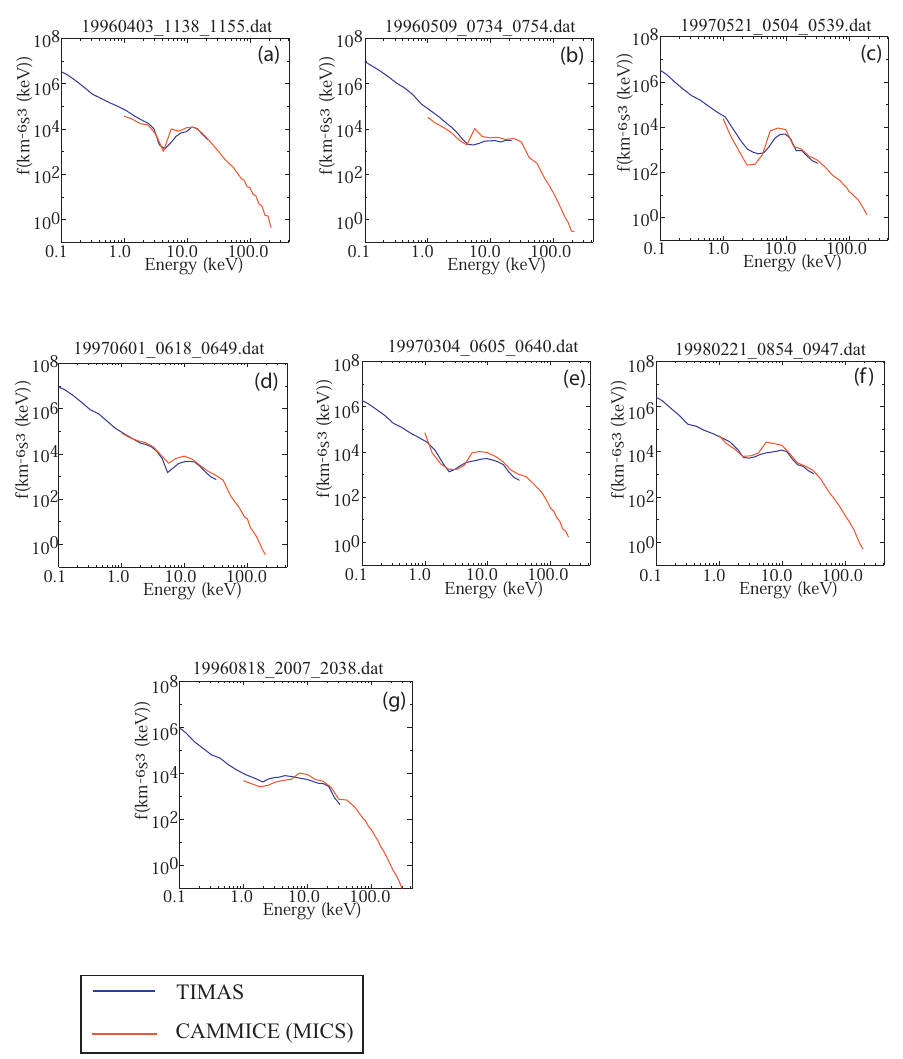
Fig. 4. Panels ( a ) to ( f ) – the 6 IDFs measured by the TIMAS and CAMMICE (MICS) instruments for which there were conjugate ionospheric wave observations from the DOPE HF sounder. Panel ( g ) – An example of an IDF taken from the modal bin (0.0 to 5.6 × 10 9 J) of the Monte Carlo distribution shown in Fig. 6a. The IDF contains a positive gradient region in the form of a “shoulder” in the